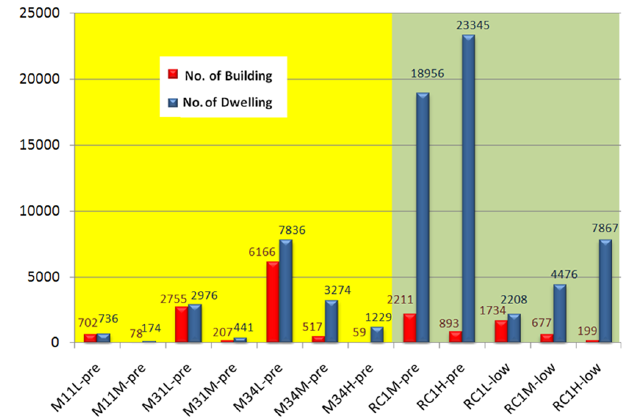
Fig. 7. Distribution of buildings (in red) and dwellings (in blue) per vulnerability class in the city of Almería. See text for more infor- mation.